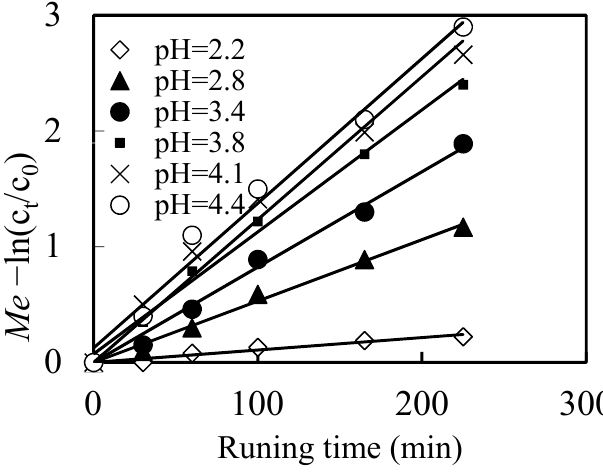
Figure 2. Effects of pH of the feeding solution on the migration efficiency ( Me ) of Mo(VI).